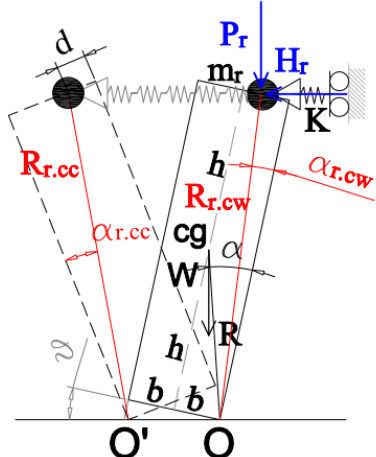
Figure 2. The rocking block with horizontal elastic restraint and roof mass.